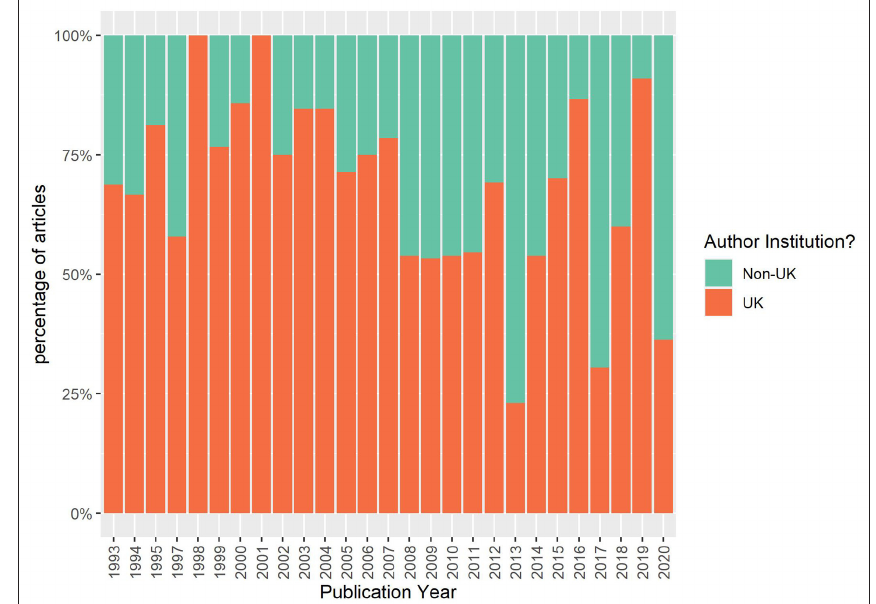
Figure 12: Author institution location per year (UK and rest of